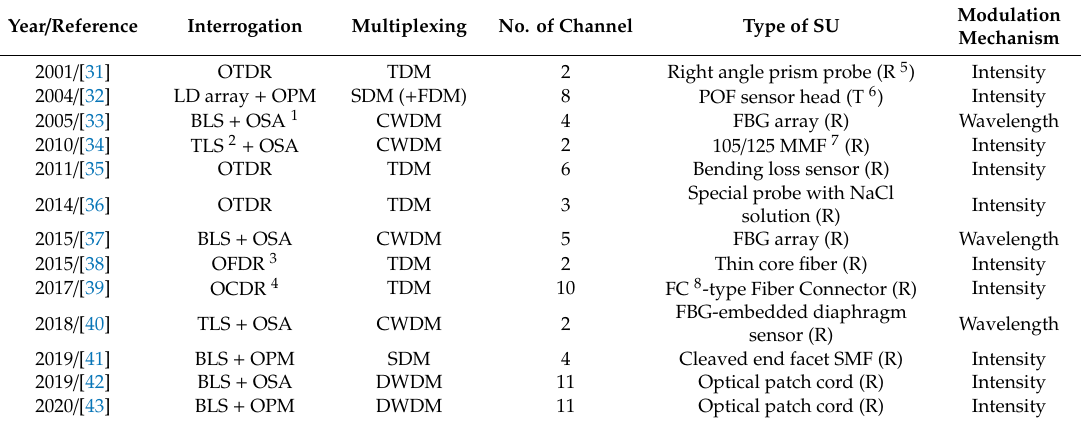
Table 2. State-of-the-art of multiplexed optical fiber sensor networks for water level